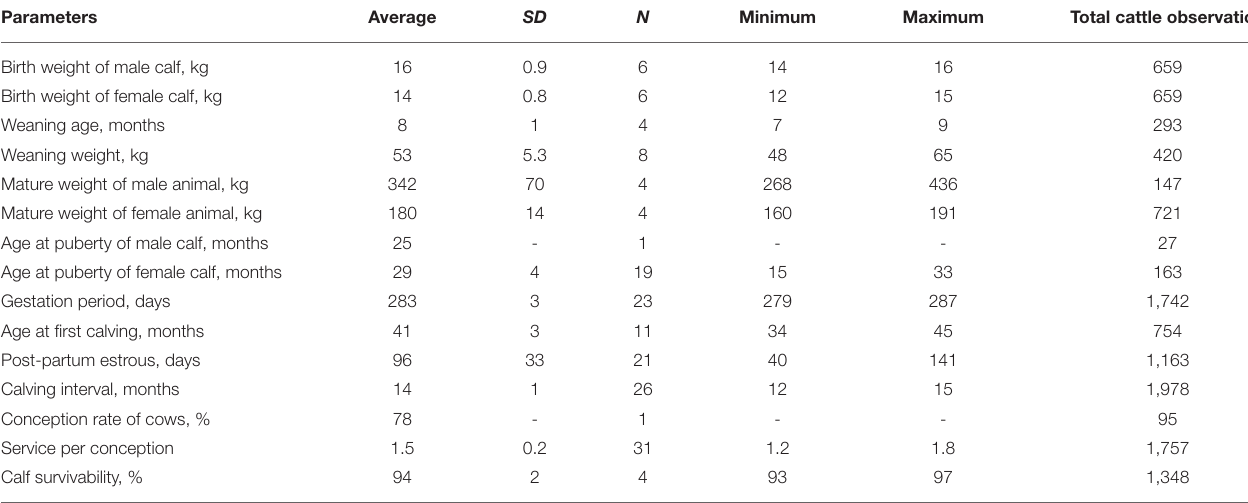
TABLE 5 | Productive and reproductive traits of Red Chittagong cattle. Parameters Average SD N Minimum Maximum Total cattle observation